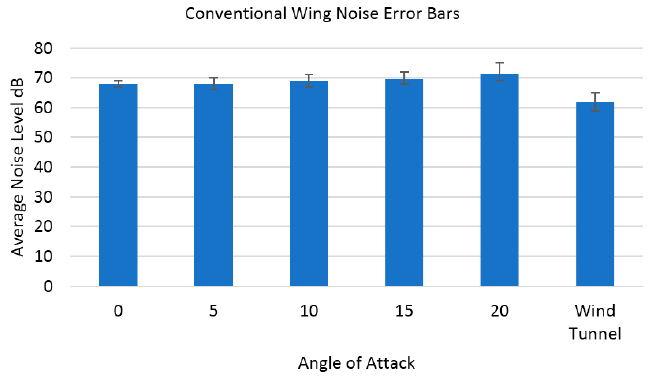
Figure 32. Conventional wing noise error bars.